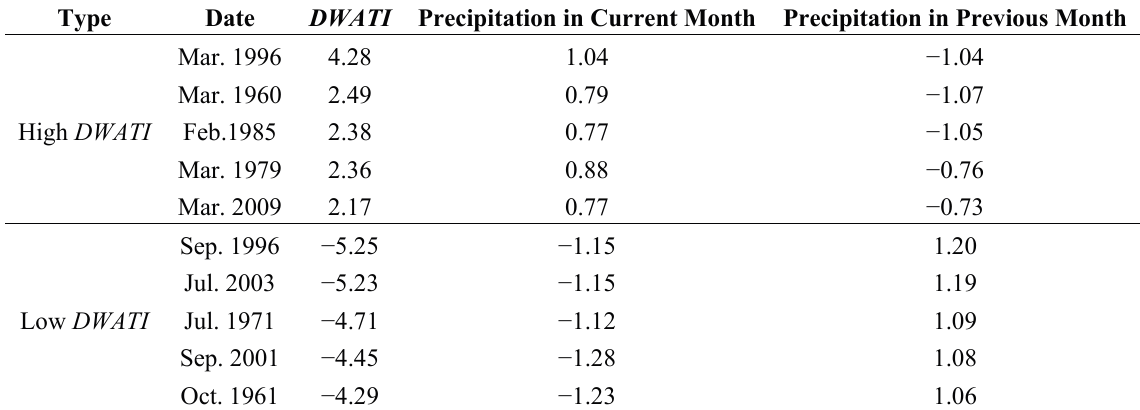
Figure 3. Variation of monthly DWATI (dry-wet abrupt transition index) during 1960–2010. Table 1. Comparison of normalized precipitation for the chosen five highest and lowest DWATI in the current month and previous